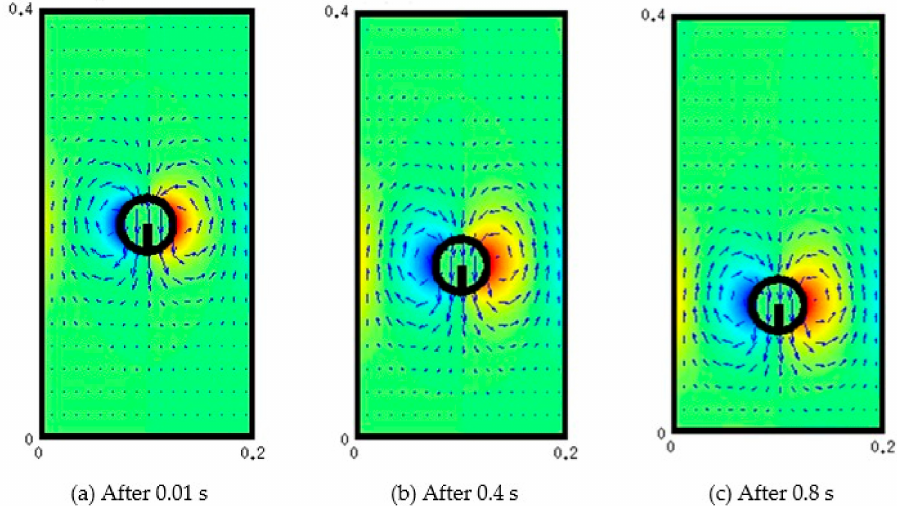
Figure 10. Succession of particle motion ( ρ s = 3000, ρ f = 1000, µ s = 1000, µ f = 17.72).